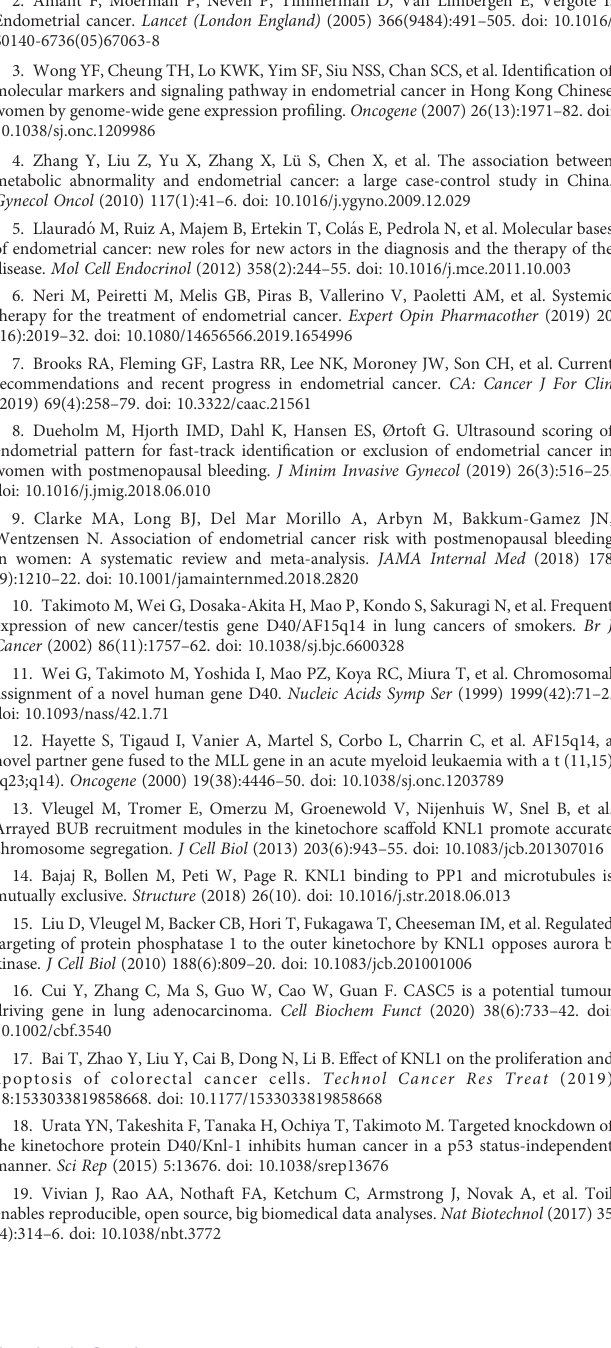
SUPPLEMENTARY FIGURE 3 KM overall survival curves strati fi ed by KNL1 expression in different tumors. (A) KM survival curve of GBMLGG, (B) KM survival curve of LGG, (C) KM survival curve of BRCA, (D) KM survival curve of KIRP, (E) KM survival curve of KIRC, and (F) KM survival curve of